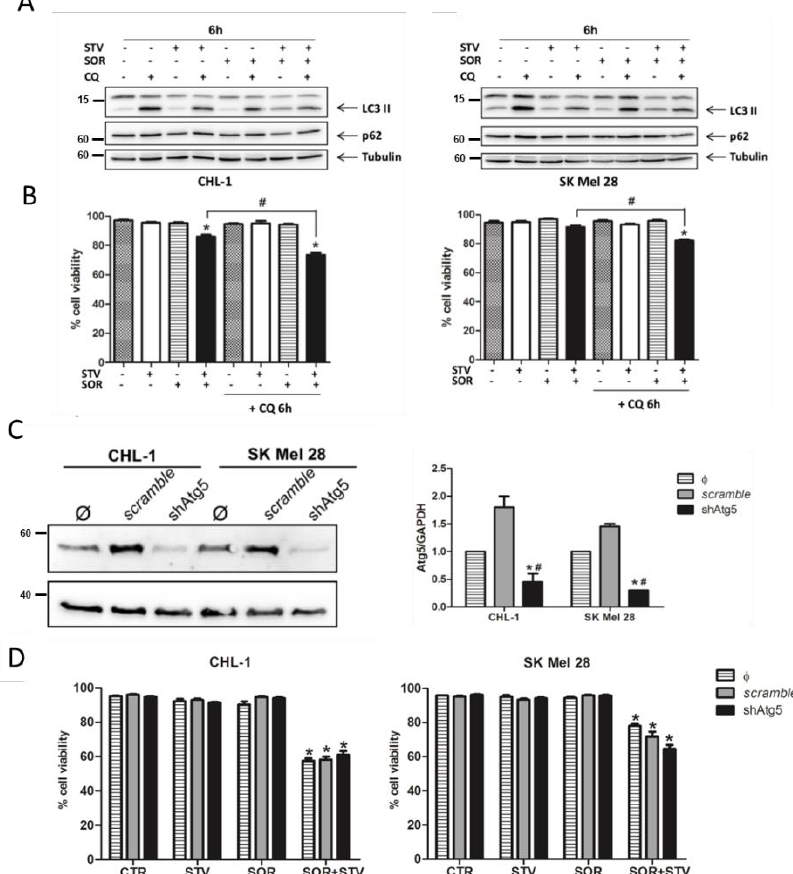
Figure 5. Late-stage autophagy blockage is involved in SOR + STV-induced cell death of melanoma cells. ( A ) Autophagy was evaluated by western blotting analysis, by measuring LC3 conversion and p62 degradation in CHL-1 and SK Mel 28 cells exposed 6 h to EBSS (STV), SOR [10 mM] or SOR + STV, in presence or absence of the autophagic inhibitor chloroquine (CQ 25 mM). Tubulin was used as loading control (Images are representative of three independent experiments). ( B ) Cell viability of CHL-1 and SK Mel 28 was also performed in the same experimental conditions reported in A. (Histograms represents mean ± SD; n = 3) * p < 0.005 compared to control cells. # p < 0.0001 absence vs. presence of CQ. ( C ) ATG5 expression was abrogated in both CHL-1 and SK Mel 28 by transducing cells with lentiviral particles carrying a specific shRNA sequence for Atg5 (shAtg5) or a scrambled sequence (scramble). Atg5 protein levels were evaluated by western blotting analysis (left panel) and a densitometric analysis (Atg5 normalized by GAPDH) was also performed (right panel). GAPDH was used as loading control. (Images are representative of three independent experiments; histograms represent mean ± SD, n = 3) * p < 0.0001 compared to not transduced cells ( Φ ); # p < 0.0001 compared to scramble cells. ( D ) Cell viability was evaluated by flow cytometry in both control cells and shAtg5 cells under STV, SOR, or combined treatment (SOR + STV), at 6 h post treatment. (Histograms represent mean ± SD; n = 3) * p < 0.0001 compared to untreated cells